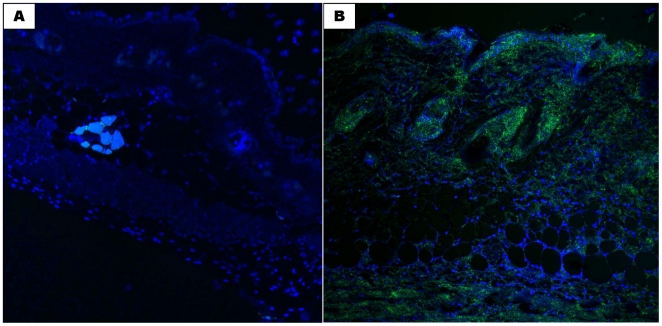
Topical SAGE penetrates into inflamed mouse skin.Balb/c mice were injected intradermally with LL-37 every 12 h for 48 h as in Figure 7. Control emollient [3% (w/w) methylcellulose] or emollient containing Alexa Fluor 633-labeled GM-1111 was applied topically to the injected skin after the last two LL-37 injections. Under low light conditions, skin was harvested 12 h after the last emollient application, fixed in paraformaldehyde and embedded in paraffin. Slides were deparaffinized with xylene, stained with DAPI (1∶100 dilution in fluorescent mounting medium) and imaged using an FV1000 confocal microscope. The skin surface is oriented at the top of each image. A. Skin from controls demonstrates blue DAPI (λex = 358 nm; λem = 461 nm) image but no SAGE fluorescence. B. Skin treated with Alexa Fluor 633-labeled GM-1111 demonstrates fluorescence (λex = 633 nm; λem = 647 nm; false colored green in the image) consistent with SAGE penetration into LL-37-inflamed skin.